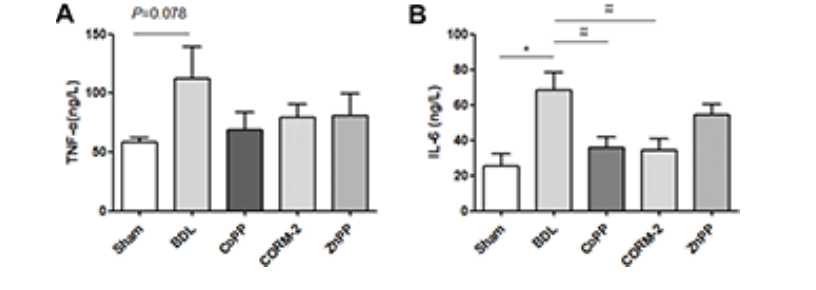
Figure 3. Intestinal TNF- α and IL-6 detection by ELISA assay in Sham/BDL rats. (A) TNF- α ; (B) IL-6. Intestinal IL-6 expression was significantly increased in the BDL group compared with the Sham group, and CORM-2 or CoPP treatment decreased intestinal IL-6 expression. * P < 0.05 compared with the Sham; # P < 0.05, ## P < 0.01 compared with the BDL